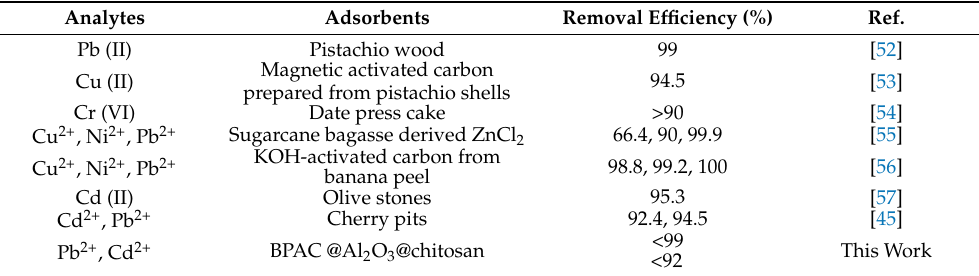
Table 5. Summary of adsorption of heavy metals using activated carbon from the agricultural